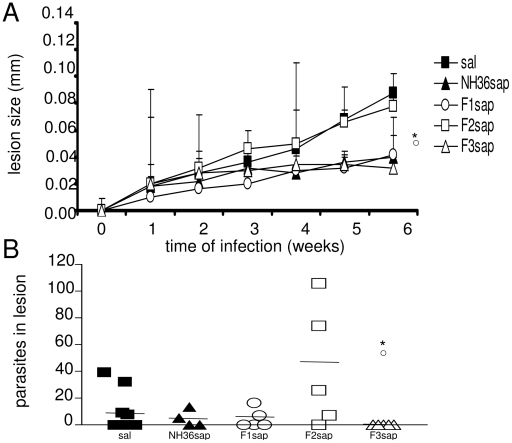
Protective efficacy of vaccinated mice against L. amazonensis infection.(A) Evolution of the size of footpad lesions of mice challenged with 105 metacyclic promastigotes of L.amazonensis one week after completing vaccinations. Results are from 2 independent experiments with 5 animals per treatment. Lesions development was followed by measuring the increment in the thickness of the infected footpad compared to the thickness of the contra-lateral non-infected footpad. Results represent the mean + SE of the footpad measurements. (B) The number of promastigotes of Leishmania amazonensis in the footpad lesions as disclosed by Real Time PCR assay. The horizontal lines represent the mean averages. *p<0.05 significant differences from the saline controls and ○ from the F2sap vaccines.